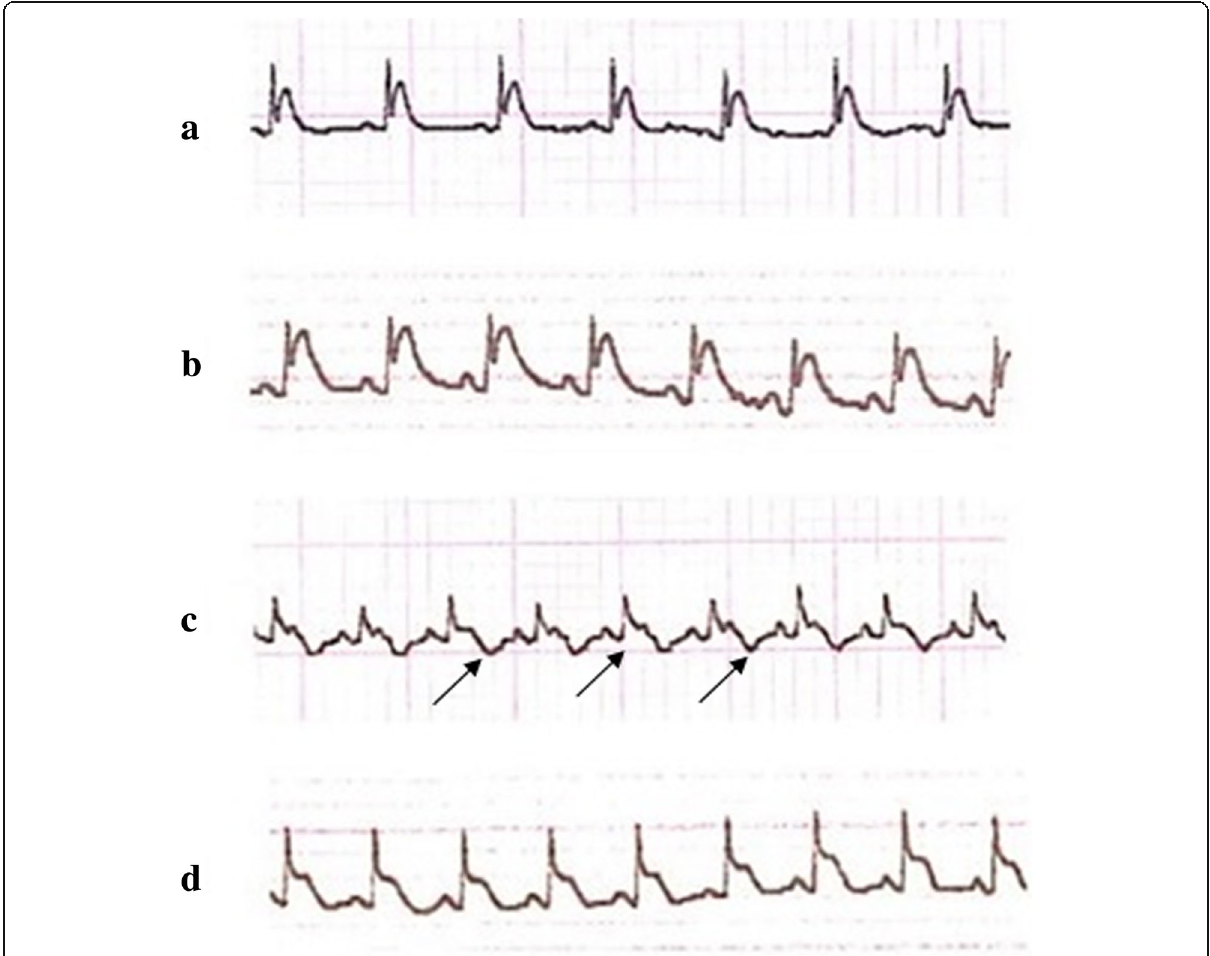
Fig. 3 Effect of MP (150 mg/kg) on ECG pattern in ISO-intoxicated rats. a Control group showing normal pattern. b MP group showing normal pattern. c ISO-intoxicated group showing inverted deep T waves, prolonged QT and QTc intervals, and widened QRS complex (arrows). d MP- pretreated group showing normal